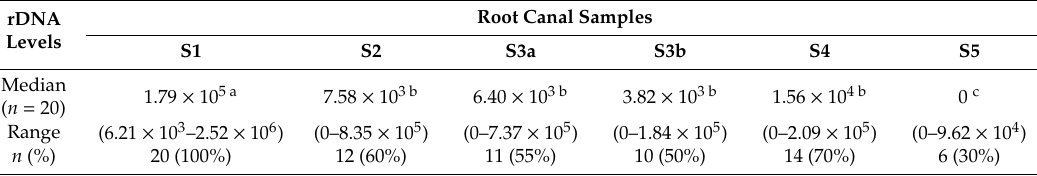
Table 2. Bacterial rDNA detection by qPCR (number of positive samples) and median values (range) of rDNA levels in root canal samples taken after access cavity (S1), root canal preparation (S2), XP-endo Finisher (S3a), passive ultrasonic irrigation (S3b), calcium hydroxide medication (S4) and 2nd-visit root canal preparation (S5).